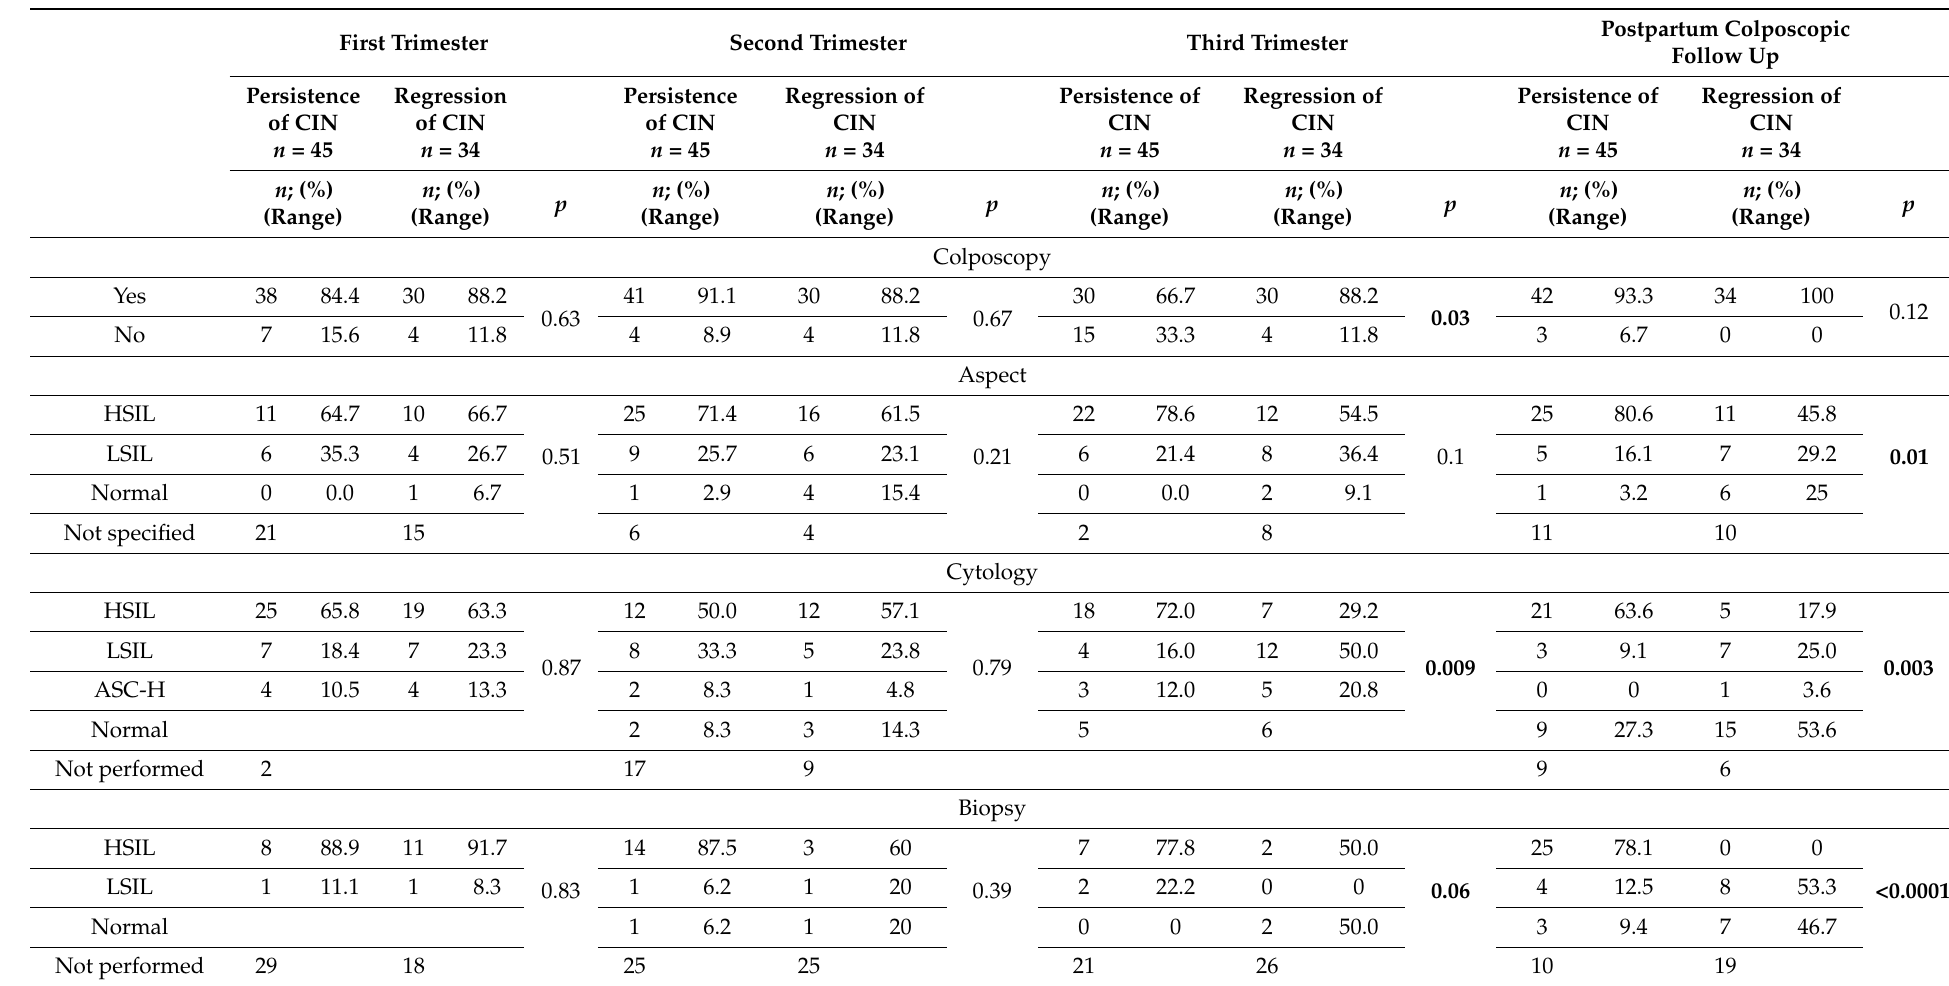
Table 4. Univariate analysis of colposcopic factors by trimester associated with postpartum CIN